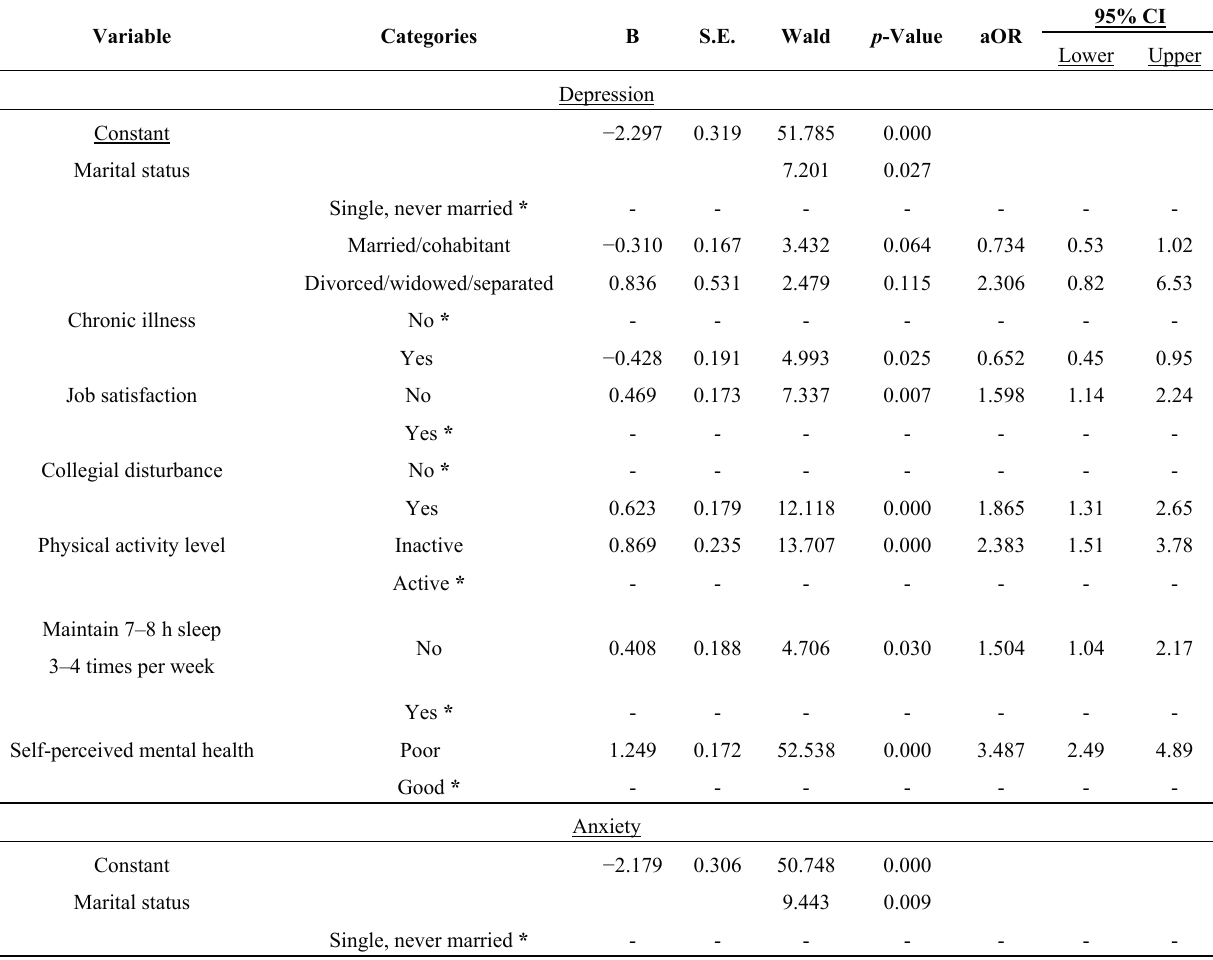
Table 5. Multiple logistic regression model predicting depression, anxiety and stress symptoms among Hong Kong